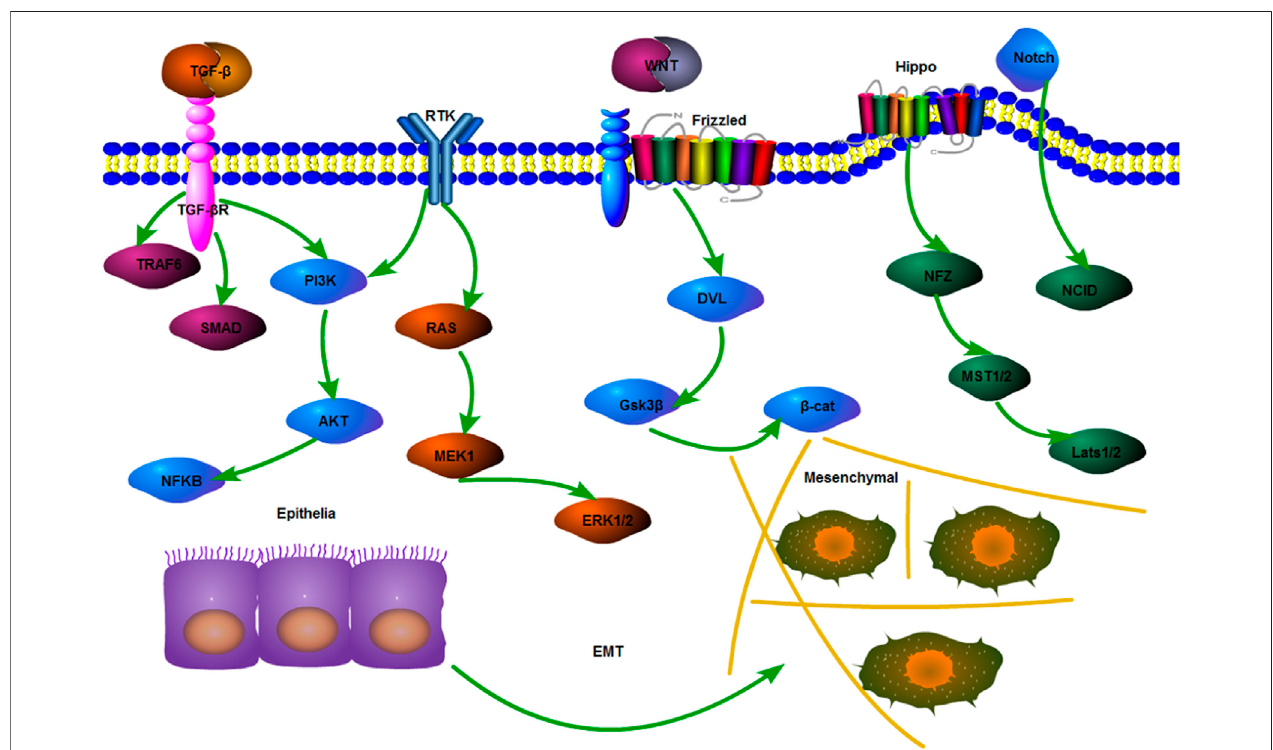
FIGURE 7 | Mechanisms of EMT-related pathways. Mechanisms of EMT-related pathways include the most classical pathway, that is, TGF- β regulates the expressionofadownstreamcellattachmentgenetolowerbyactivatingtheSmadcomplex.OtherpathwaysthatcanmaintainandpromoteEMTincludePI3K/Akt,Wnt, Hippo, and